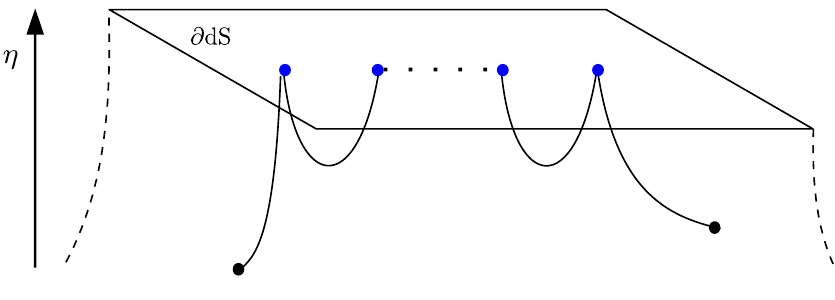
Figure 8 . A propagator dressed by insertions of a bilinear operator localized on the late time boundary of de Sitter